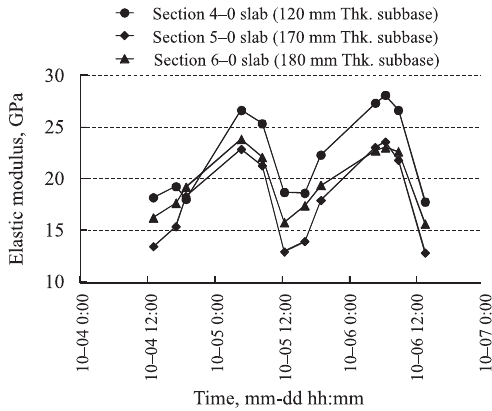
Fig. 6. Elastic modulus of concrete slab backcalculated by MET